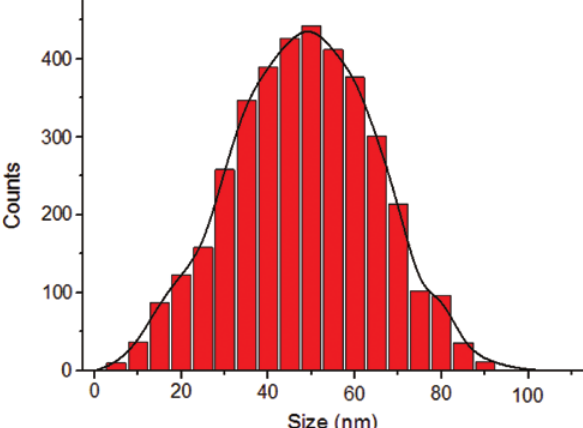
Figure 3: Particle size distribution analysis of ZnO-CeO